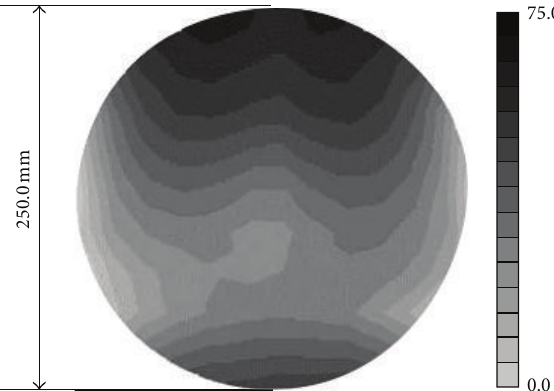
Figure 11: Height color map of a curved fixing